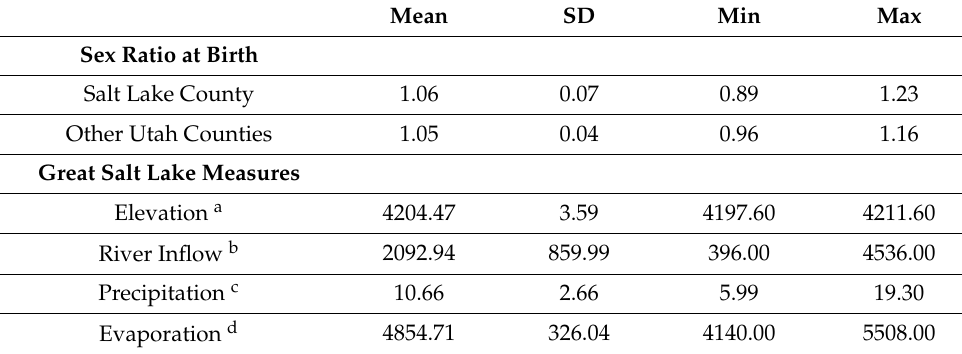
Table 1. Descriptive Statistics (N = 69 Years).